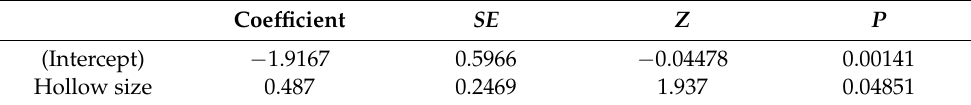
Table 5. Generalized linear model with only the hollow size as a predictor for the likelihood of C. gattii being present in a particular tree hollow. The standard error ( SE ), Z-score ( Z ) and p -values ( p ) are